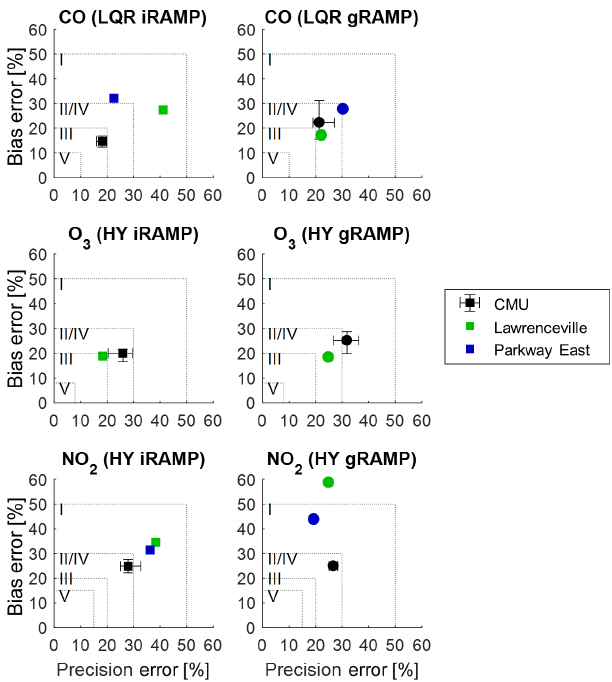
Figure 5. Comparative performance of individual and general mod- els for RAMPs deployed to ACHD monitoring stations using EPA performance criteria. Dotted lines indicate the outer limits of each performance tier. Performance shown for the CMU site is based on performance across all RAMPs at that site based on testing data only. Proximity to the lower-left corner of each figure indicates bet- ter